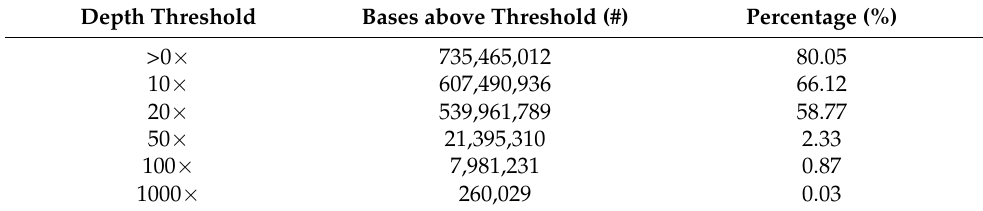
Table 2. Average breadth of coverage across Iowa